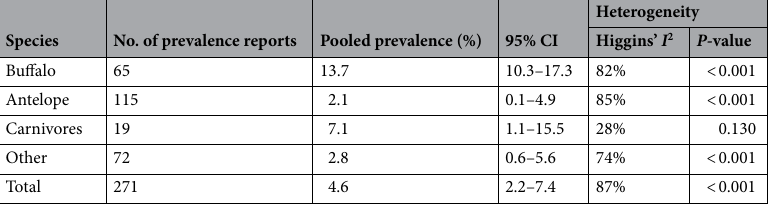
Species No. of prevalence reports Pooled prevalence (%) 95%